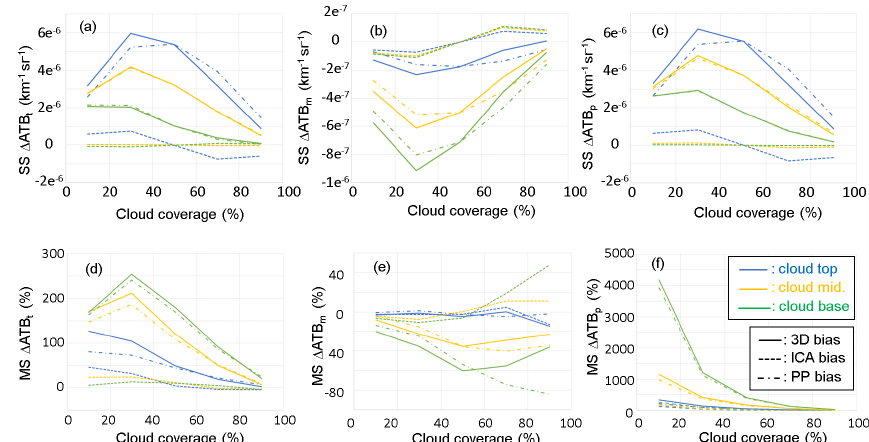
Figure 15. ICA (dashed), PP (dotted dashed), and 3D (full line) biases under the single-scattering (SS) regime on (a) total ATB, (b) molecular ATB, and (c) particulate ATB as a function of cloud coverage (%) inside the lidar receiver FOV computed at cloud top (9.8 km, blue curves), in the middle of the cloud (9.5km; yellow curves), and at cloud base (9.2 km; green curves). Panels (d) , (e) , and (f) are the same as (a) , (b) , and (c) but for relative bias and the MS regime. Cloud optical depth is 3.